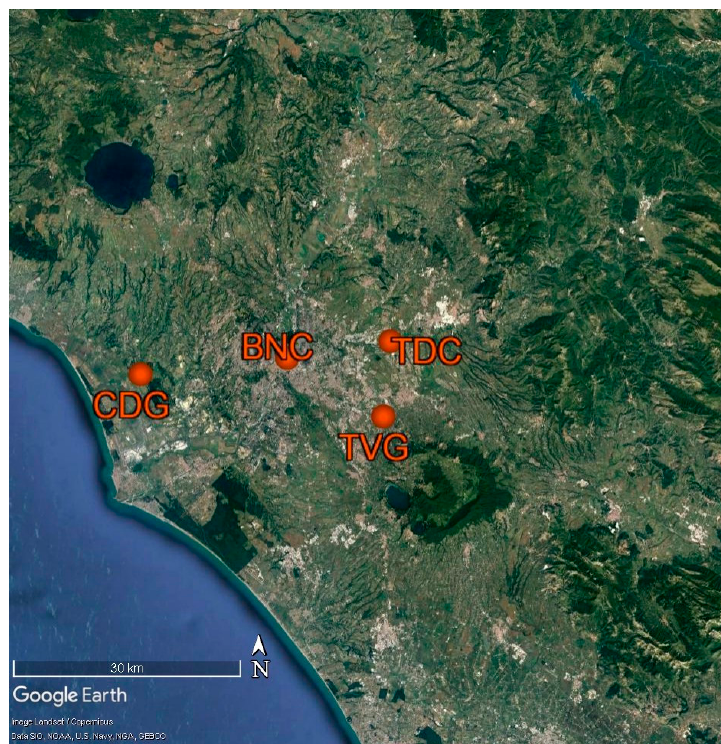
Figure 1. Location of the ARPA Lazio micro-meteorological network (BNCu, Rome city center; CDGr, Castel di Guido; TVGr, Tor Vergata; TDCs, Tenuta del Cavaliere).